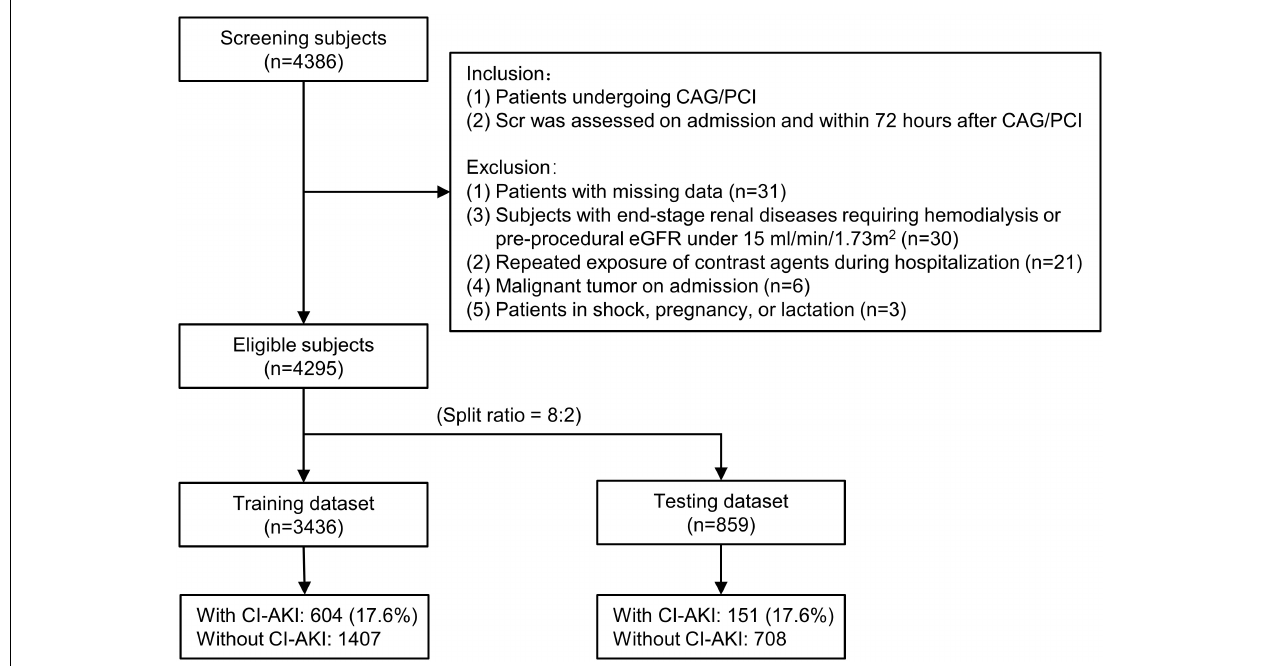
FIGURE 1 | The flow chart of the current study. CAG indicates coronary angiography; PCI, percutaneous coronary intervention; CA-AKI, contrast-associated acute kidney injury; Scr, serum creatinine; eGFR, estimated glomerular filtration rate.